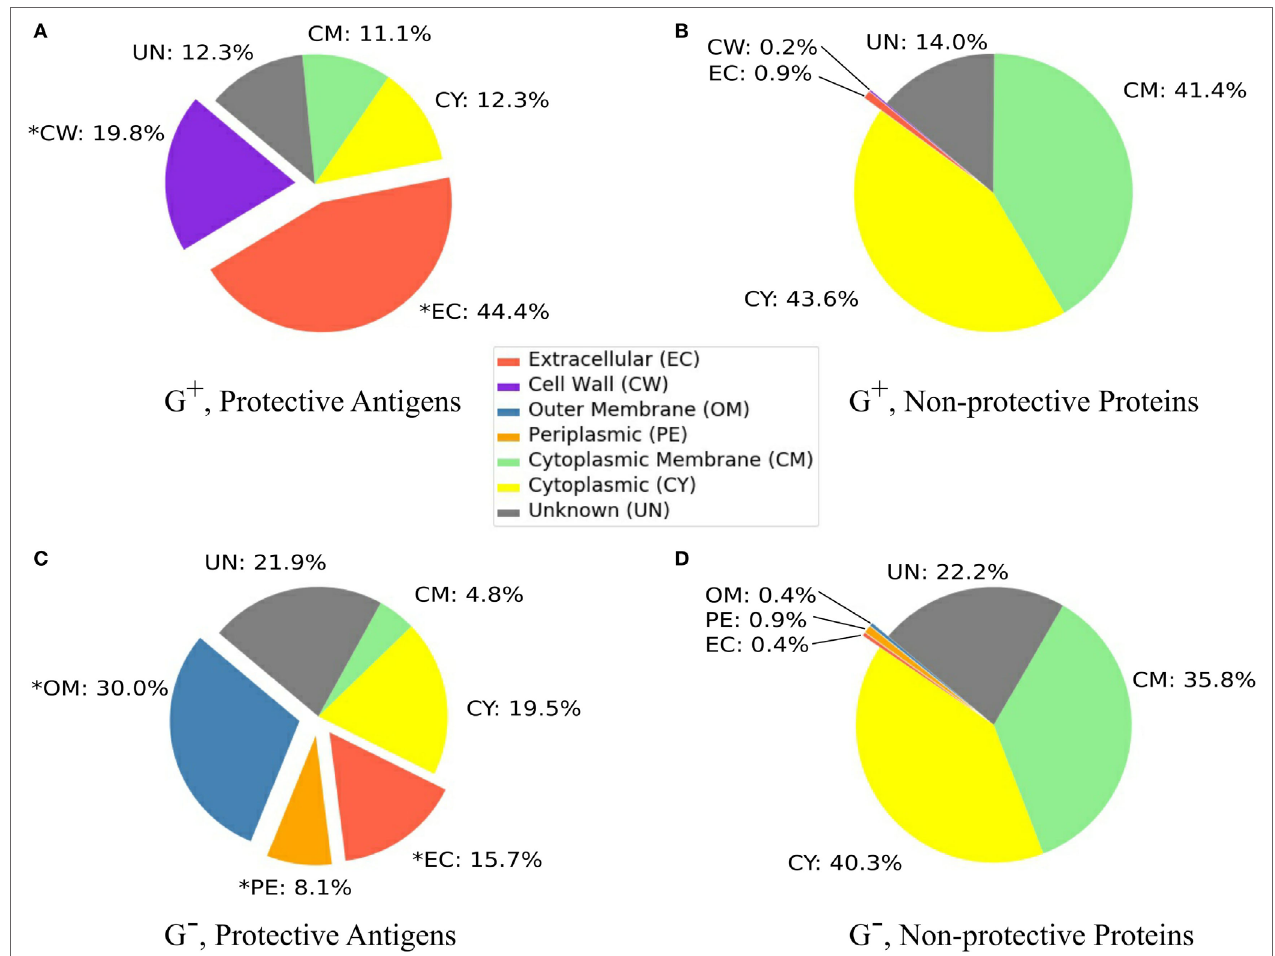
FigUre 1 | Subcellular localization profiles. G + and G − bacterial protective antigens showed significantly higher ( p < 0.01) proportions of EC (G + and G − ), CW (G + ), and PE and OM (G − ) (a,c) compared with the non-protective proteins (B,D) (abbreviations shown in the middle color key legend). Only PAgs and non-protective proteins are displayed and the composition of background proteomes and non-protective proteins are very alike (Figure S1 in Supplementary Material). The significant over-representation of PAgs’ subcellular localization prediction compared with non-protective proteins is indicated with “*” ( p <